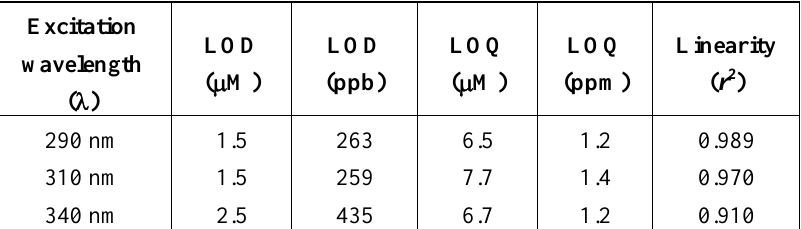
Table 1. Limits of detection (LOD) and quantitation (LOQ) of CA.*